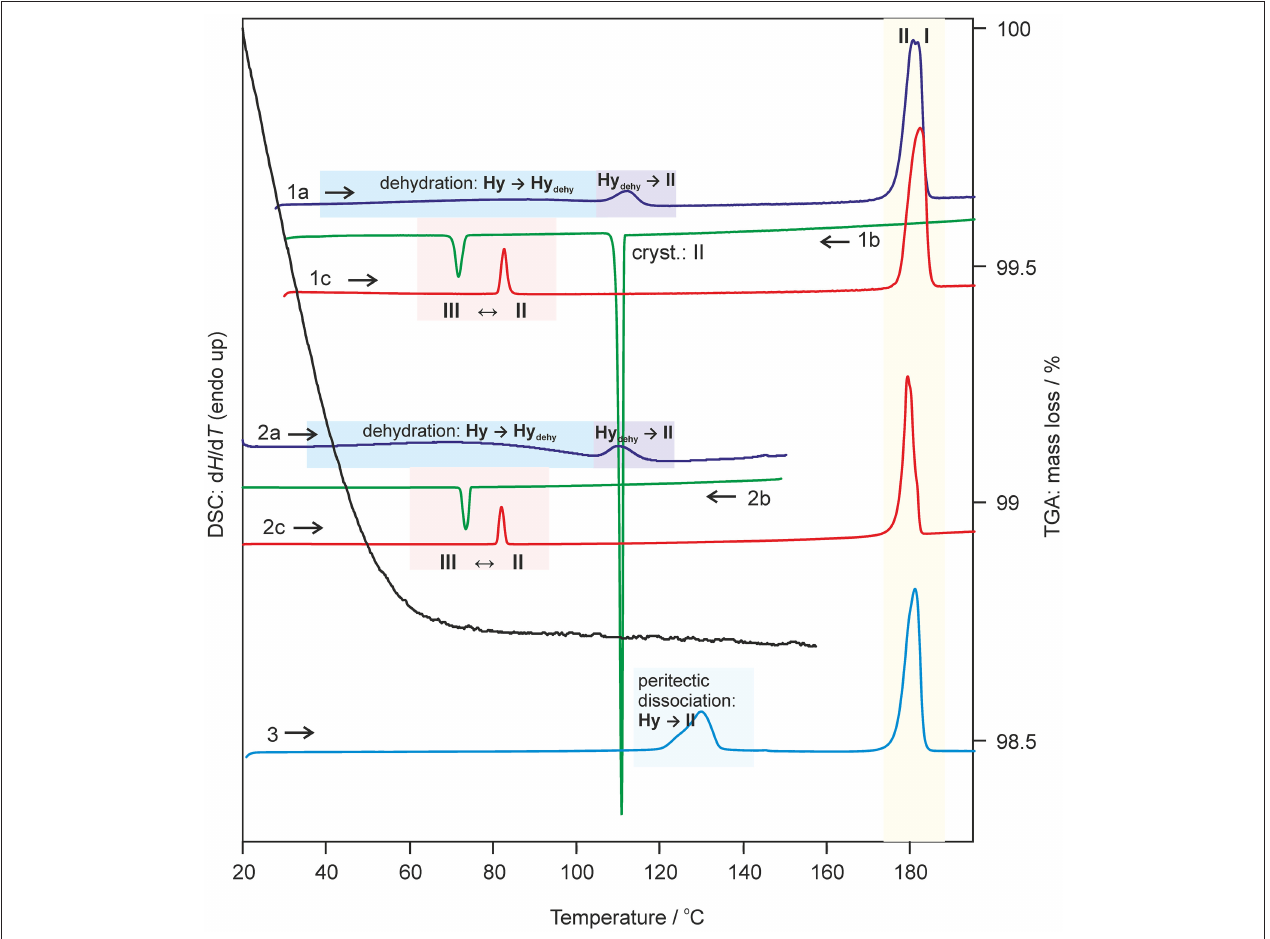
FIGURE 6 | Selected DSC and TGA thermograms of DDS 0.33-Hy , recorded using a heating/cooling rate of 10 ◦ C min − 1 . DSC curves 1 and 2 were measured using perforated DSC crucibles and curve 3 using a hermetically sealed 3bar DSC crucible. I, II, III-anhydrous forms I , II , and III ; Hy, 0.33-Hy ; dehy, Hy dehy .